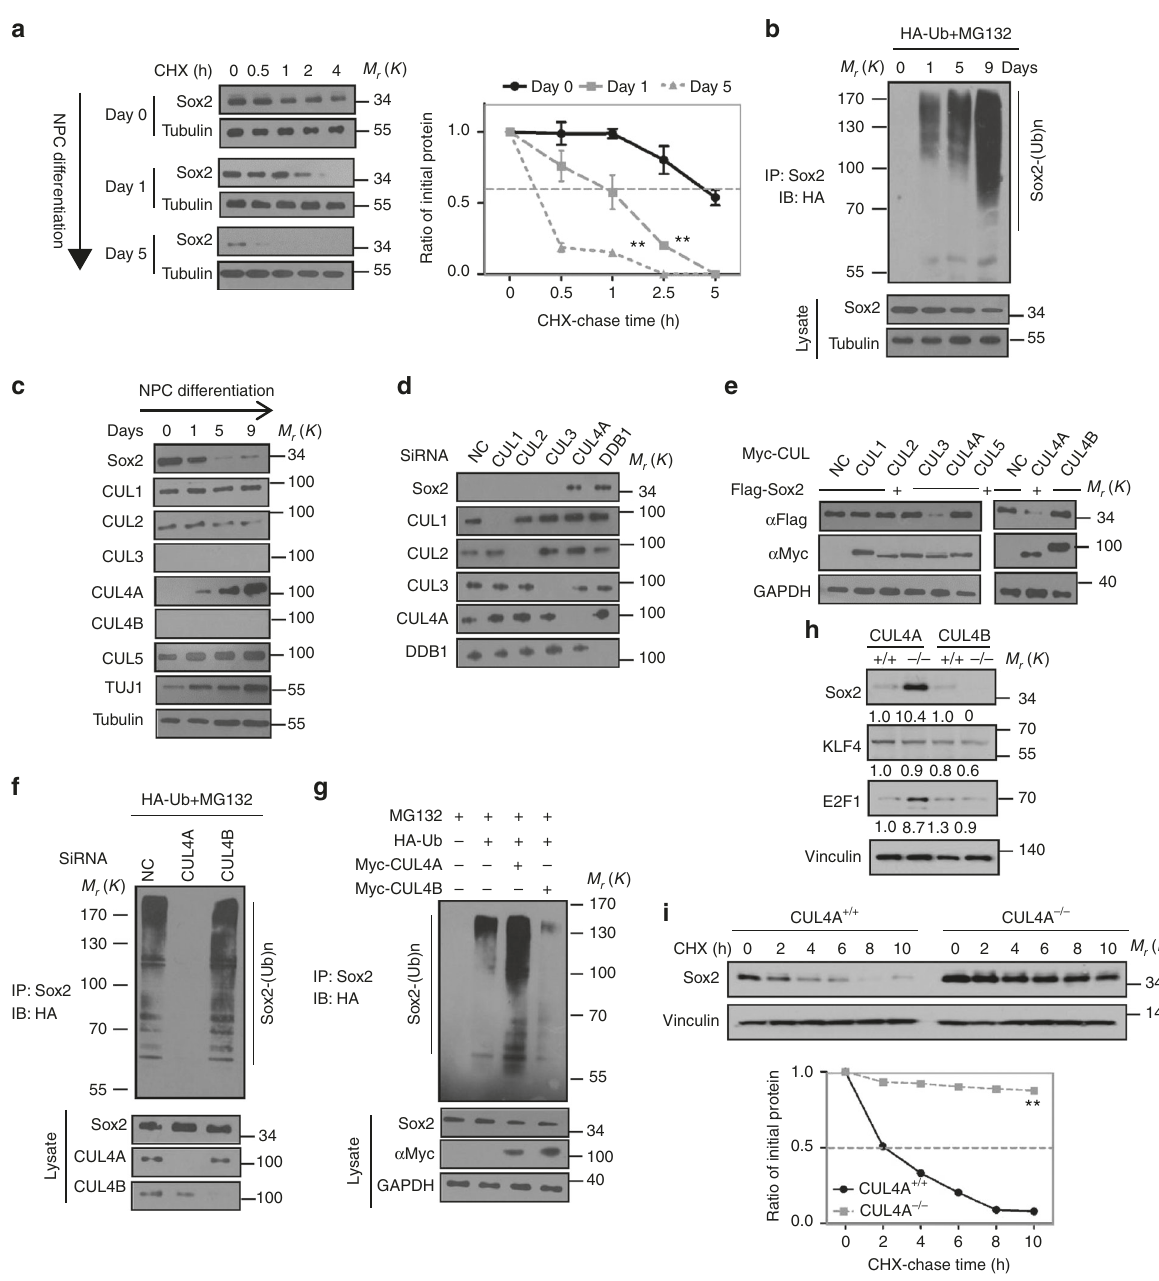
Fig. 1 CUL4A contributes to Sox2 ubiquitylation in NPCs differentiation. a NPCs (neural stem/progenitor cells derived from human NPSCs, WA09) were cultured in neural induction medium (NIM) to undergo cellular differentiation for the indicated times. NPCs were treated with 10 µ g per ml CHX, and collected at the indicated times for western blot. Quanti fi cation of Sox2 levels relative to tubulin is shown. Results are shown as mean ± s.d. n = 3 independent experiments. ** P < 0.01, two-way ANOVA test. b NPCs transfected with HA-Ub were treated with MG132 for 8 h before collection. Sox2 was immunoprecipitated with anti-Sox2 antibody and immunoblotted with anti-HA antibody. c Immunoblotting of Sox2, CUL1, CUL2, CUL3, CUL4A, CUL4B, CUL5, and TUJ1 during NPCs differentiation. d Immunoblotting of Sox2 in HEK293T cells transfected with indicated siRNA. NC represents the empty vector control. e HEK293T cells were transfected with indicated constructs and the level of Flag-Sox2 was detected by immunoblotting. NC represents the empty vector control. f , g HA-Ub was co-transfected together with indicated siRNA ( f ) or constructs ( g ) into HEK293T cells. Cells were treated with MG132 for 8 h before collection. Then Sox2 was immunoprecipitated with anti-Sox2 antibody and immunoblotted with anti-HA antibody. NC represents the empty vector control. h Immunoblotting of Sox2, KLF4 and E2F1 in MEFs with CUL4A, CUL4B knockout or WT control. Quanti fi cation of protein levels relative to vinculin is shown. i MEFs were treated with CHX (10 µ g/ml), and collected at the indicated times for western blot. Quanti fi cation of Sox2 levels relative to vinculin is shown. ** P < 0.01, two-way ANOVA test. The representative images are shown from three independent experiments. Unprocessed original scans of blots are shown in Supplementary Fig.